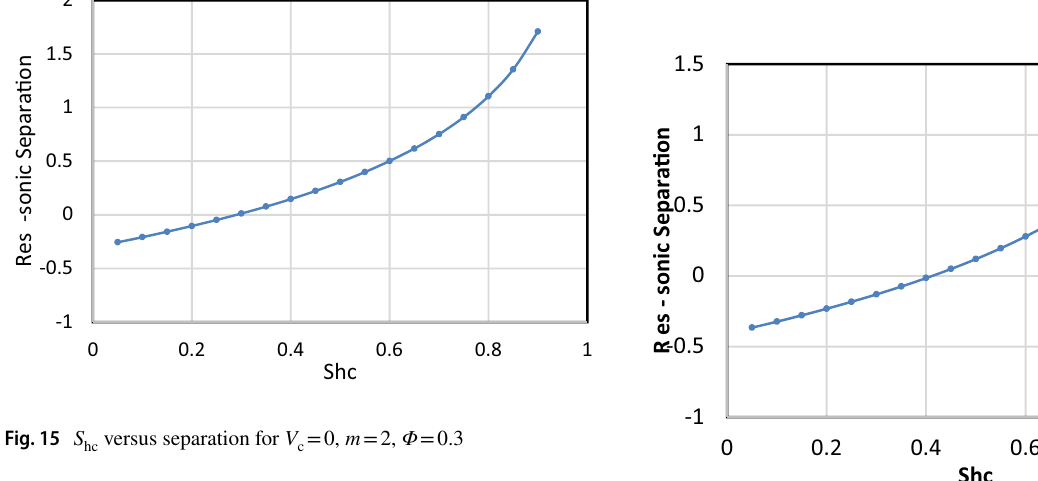
V m = 2, Φ = 0.1 c = 0,